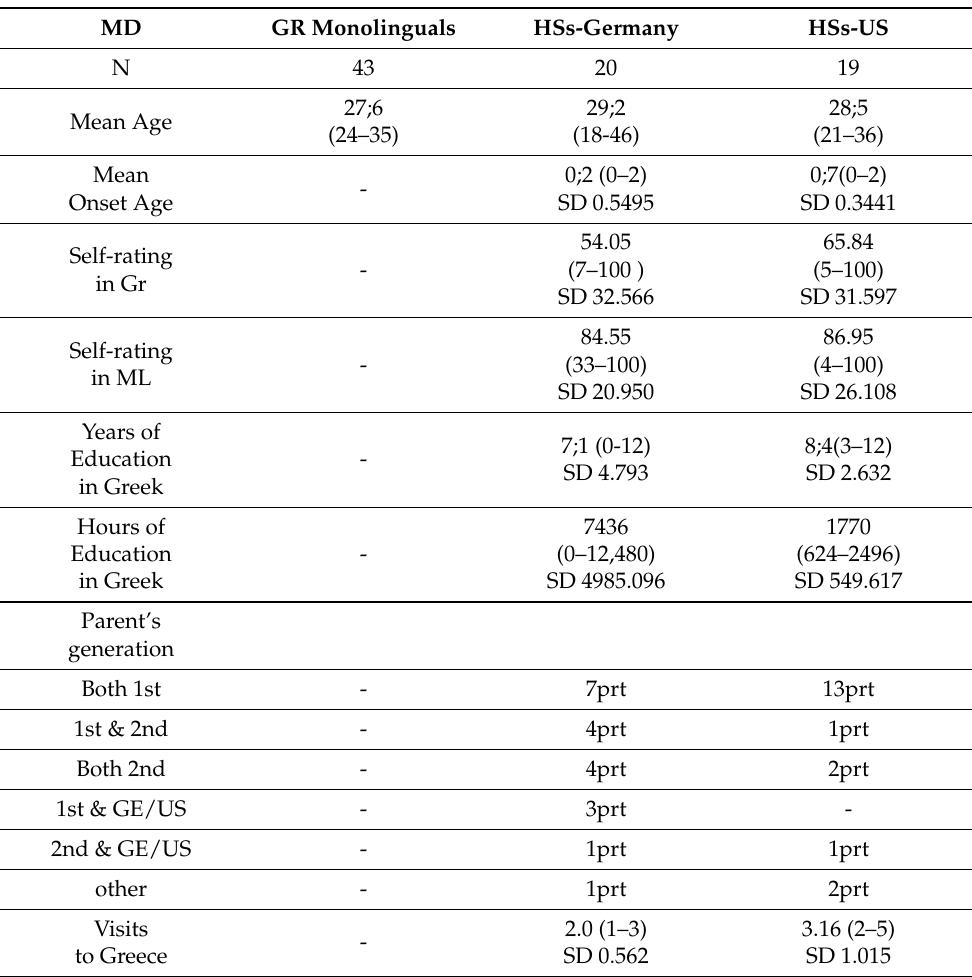
Table 6. Metalinguistic data across groups in the Sentence Evaluation